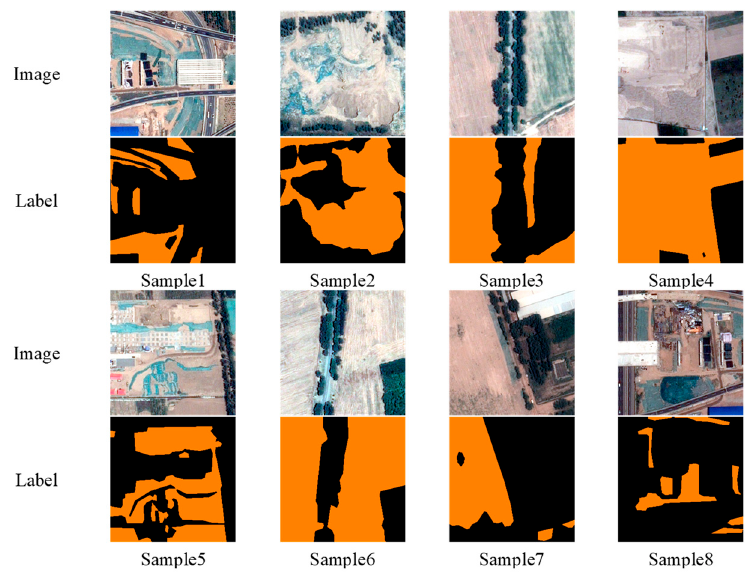
Figure 3. Examples of labeling BSL samples for the BSL dataset. Table 1. BSL dataset.